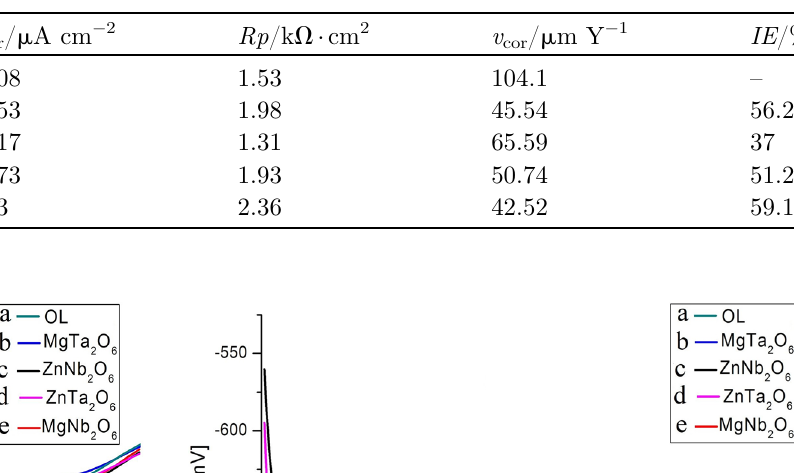
SO solution. 2 4